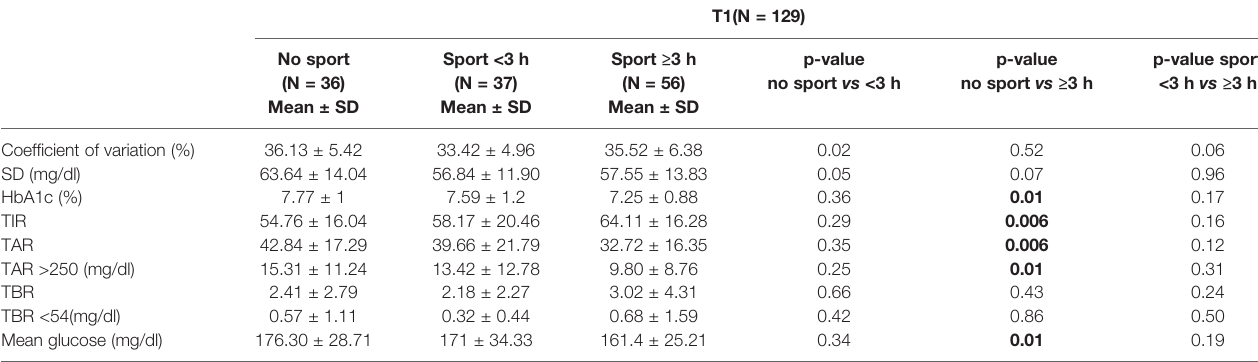
TABLE 6 | Analysis of the data at T1 of the 129 patients belonging to the “ intense physical activity ” group at